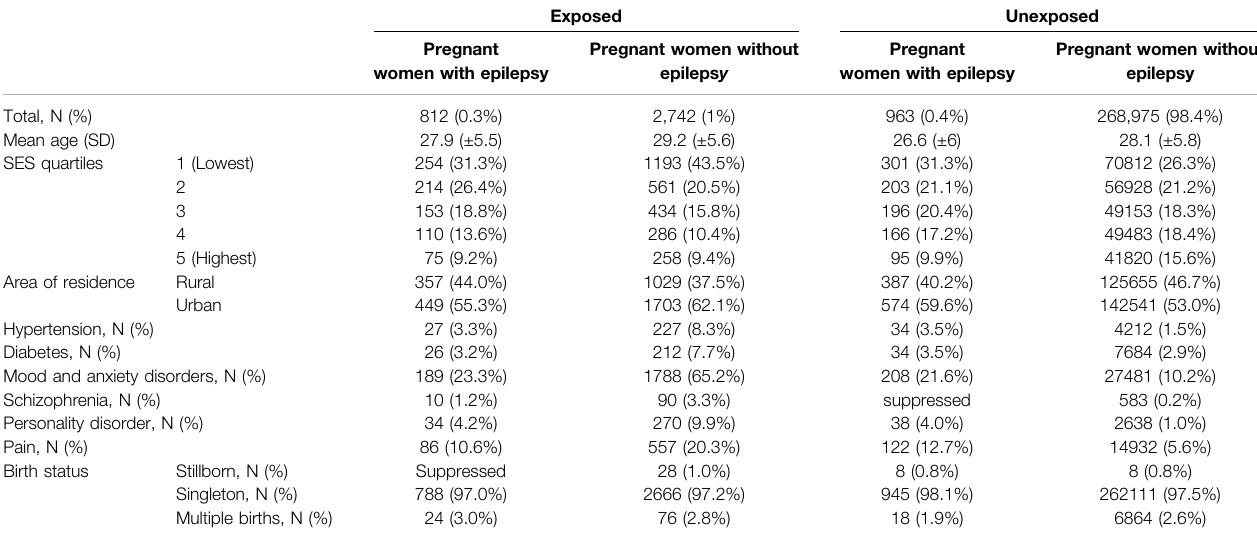
Exposed Unexposed